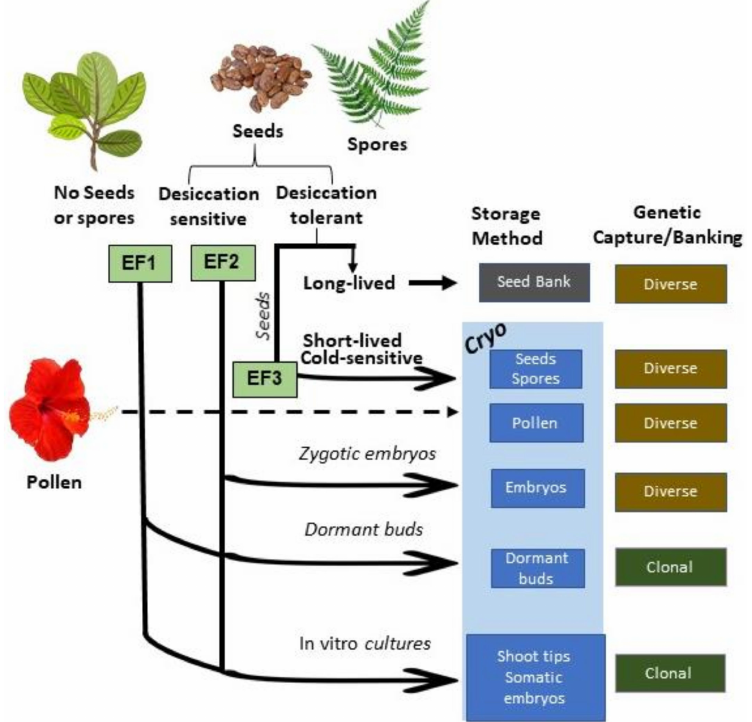
Figure 1. The role of cryopreservation in conserving plant seeds and tissues ex situ and relationship to exceptionality factor (EF) and genetic capture. EF1 = seeds unavailable; EF2 = seeds desiccation sensitive; EF3 = seeds